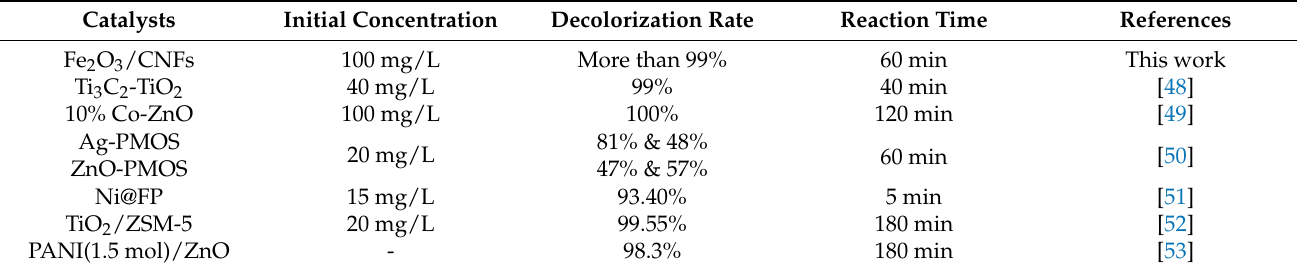
Table 1. Comparison with previous studies reported for catalytic degradation of MO.